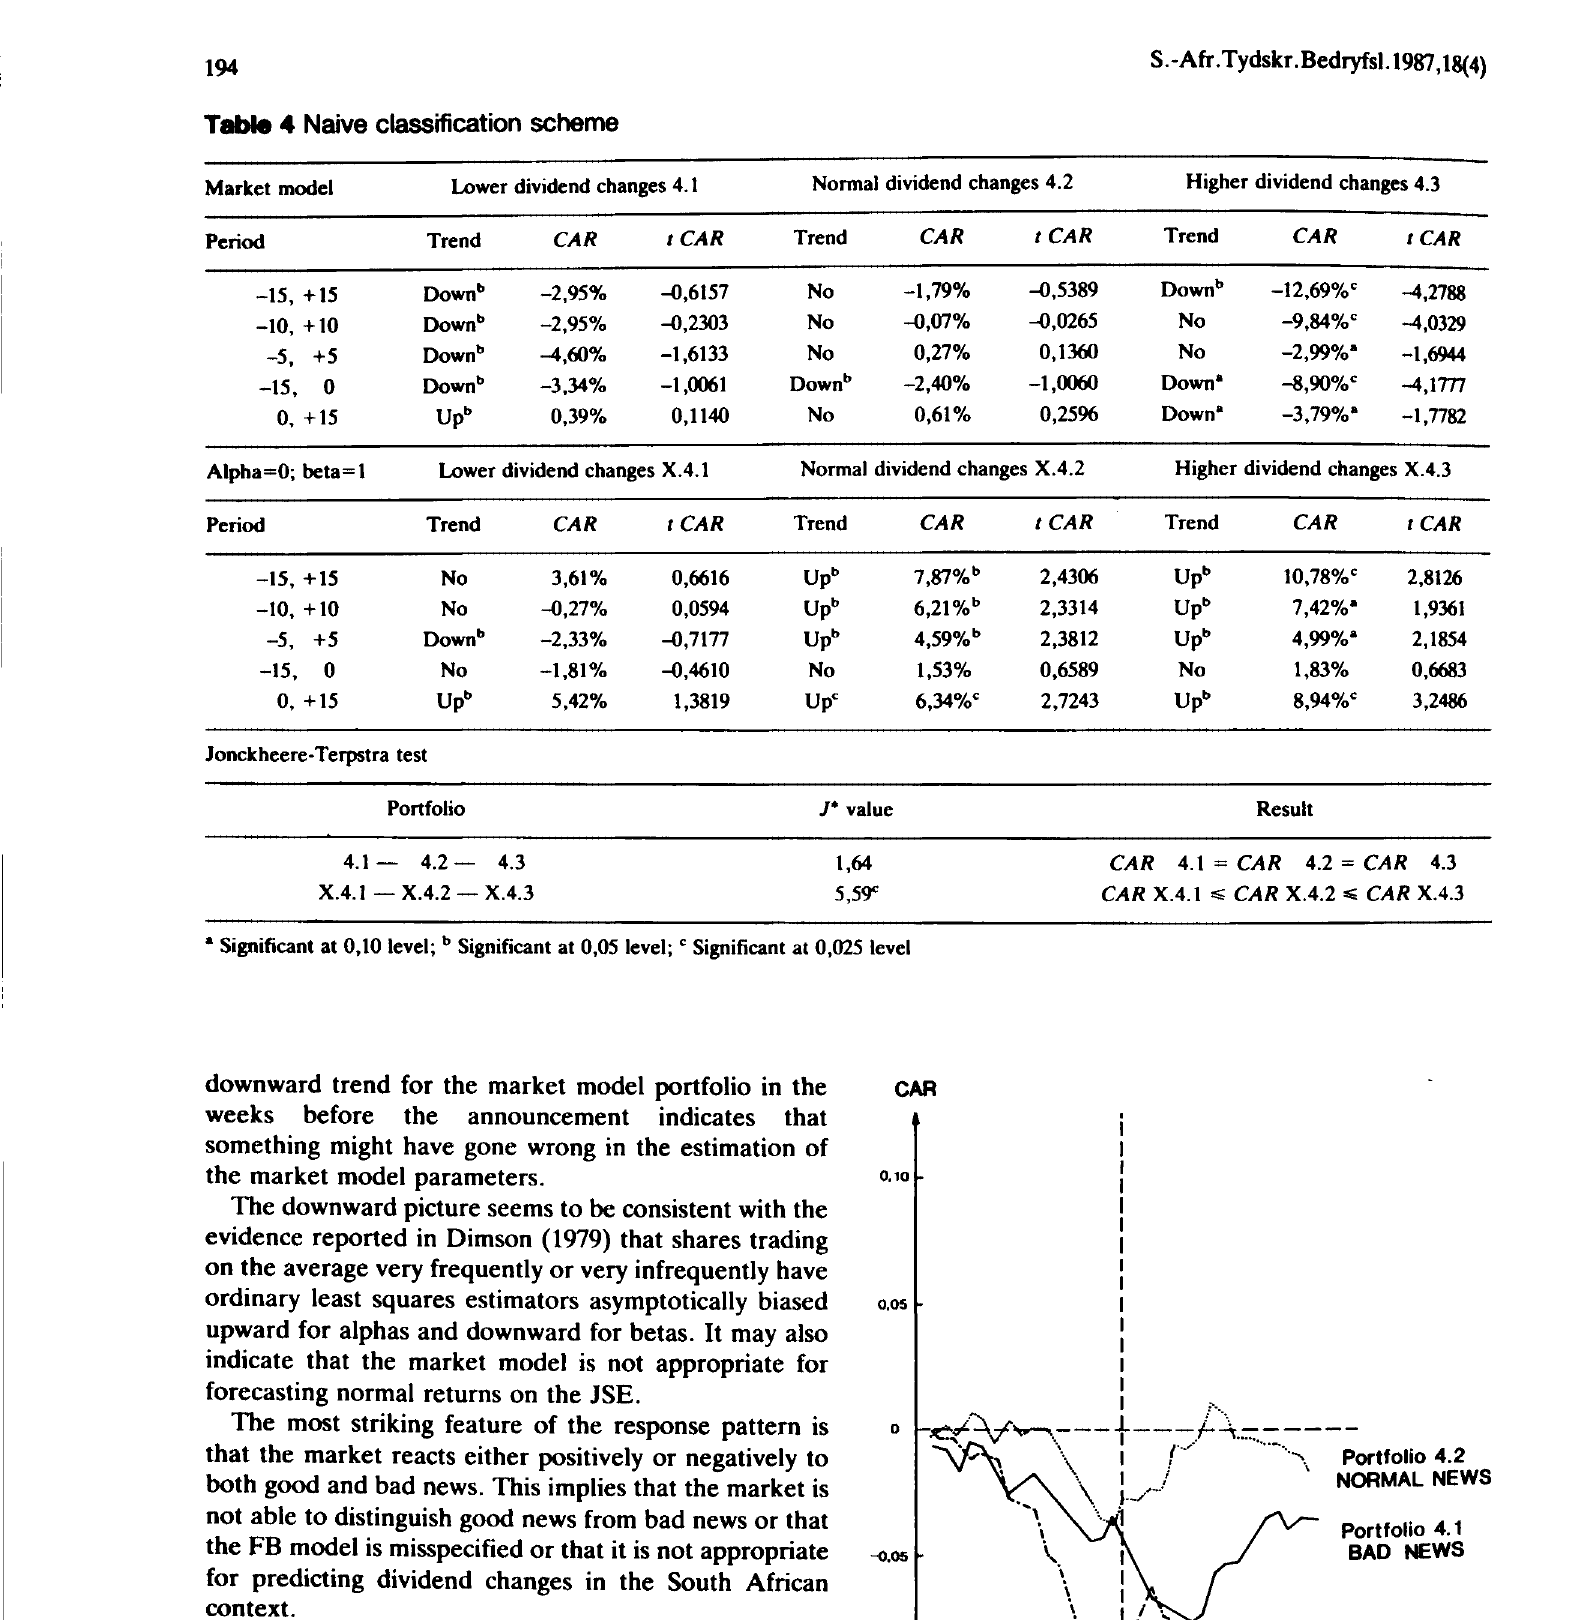
Fig&.re 4 CAR graph - all shares - market model - relative dividend